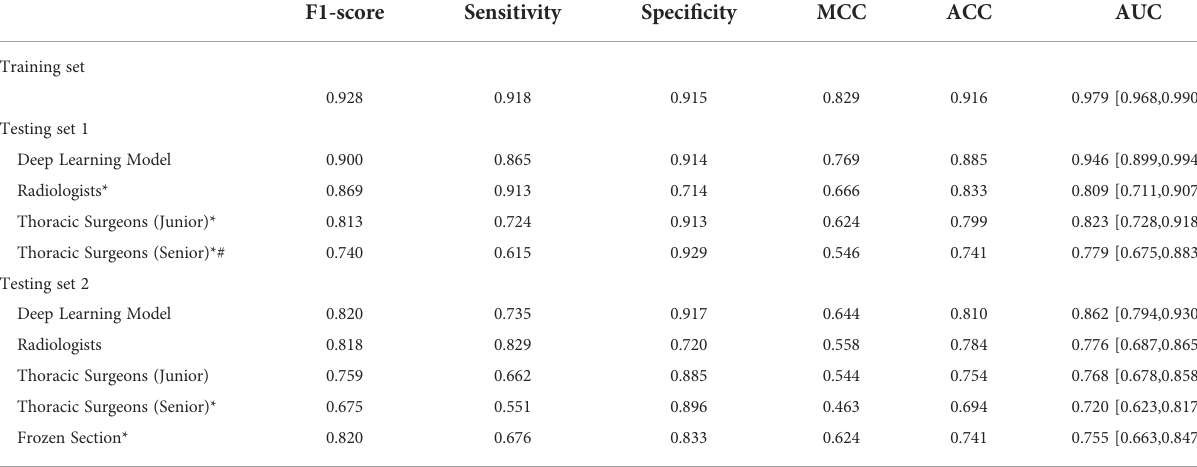
TABLE 2 The performance of overall nodules with various methods for predicting pathological